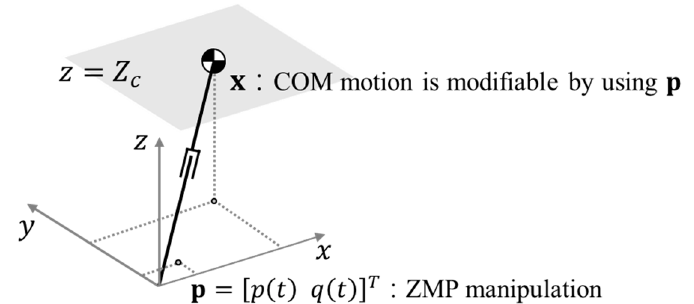
Figure 1. Three-dimensional (3-D) linear inverted pendulum model (LIPM) with zero moment point (ZMP) manipulation.